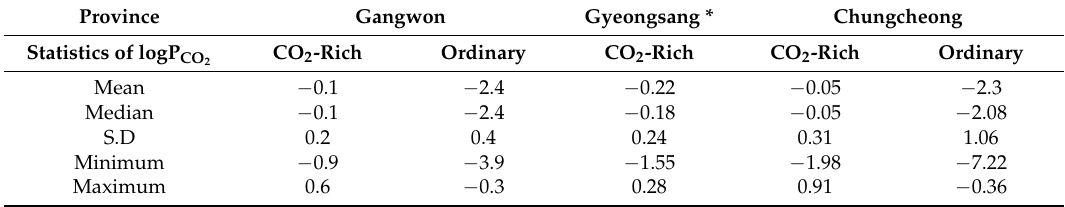
Table 14. logP CO of the CO 2 -rich and ordinary groundwaters for the three 2